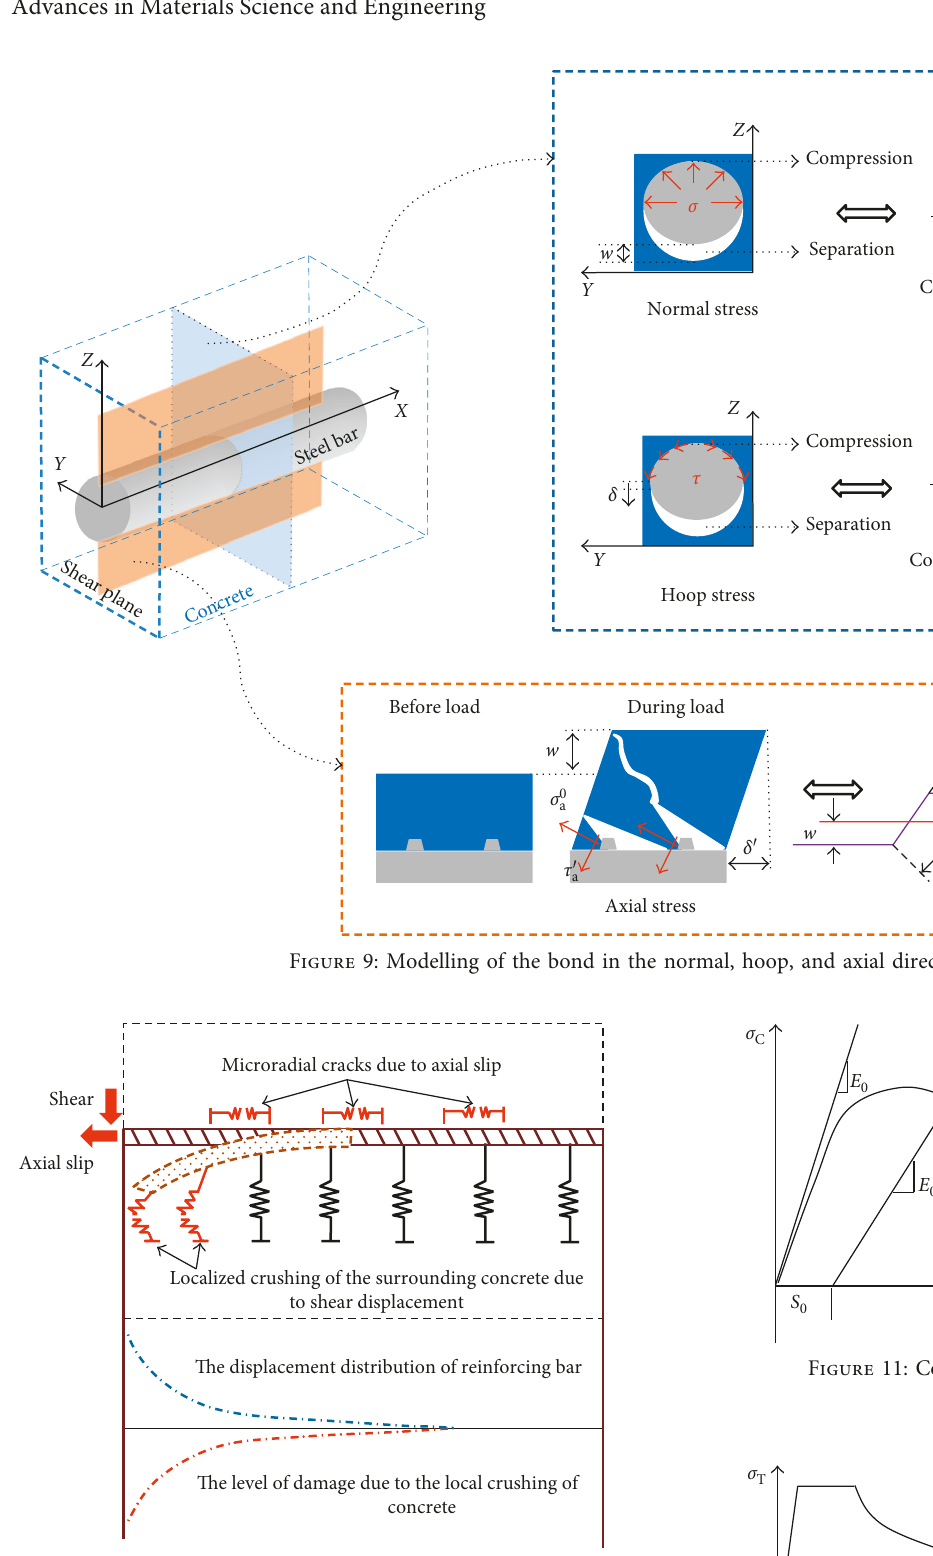
Figure 10: Coupled damage effect of the bong behavior.